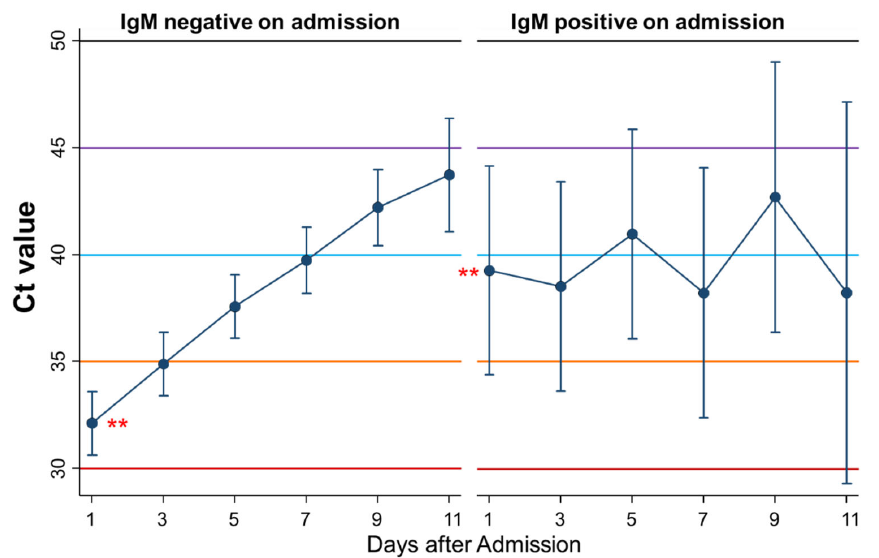
Figure 9. Differential kinetics of Ct values between patients who were IgM negative and IgM positive on admission. Mean Ct with 95% confidence intervals. When the Ct value is 40 or more, the PCR test result is considered negative. ** represents a significant difference ( p < 0.005).